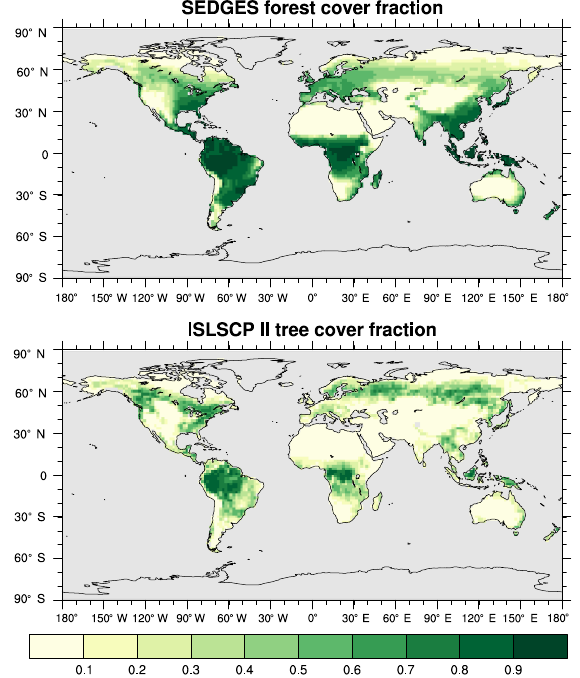
Figure 19. Mean forest cover fraction for SEDGES and tree cover fraction from the reference ISLSCP II dataset (DeFries and Hansen,